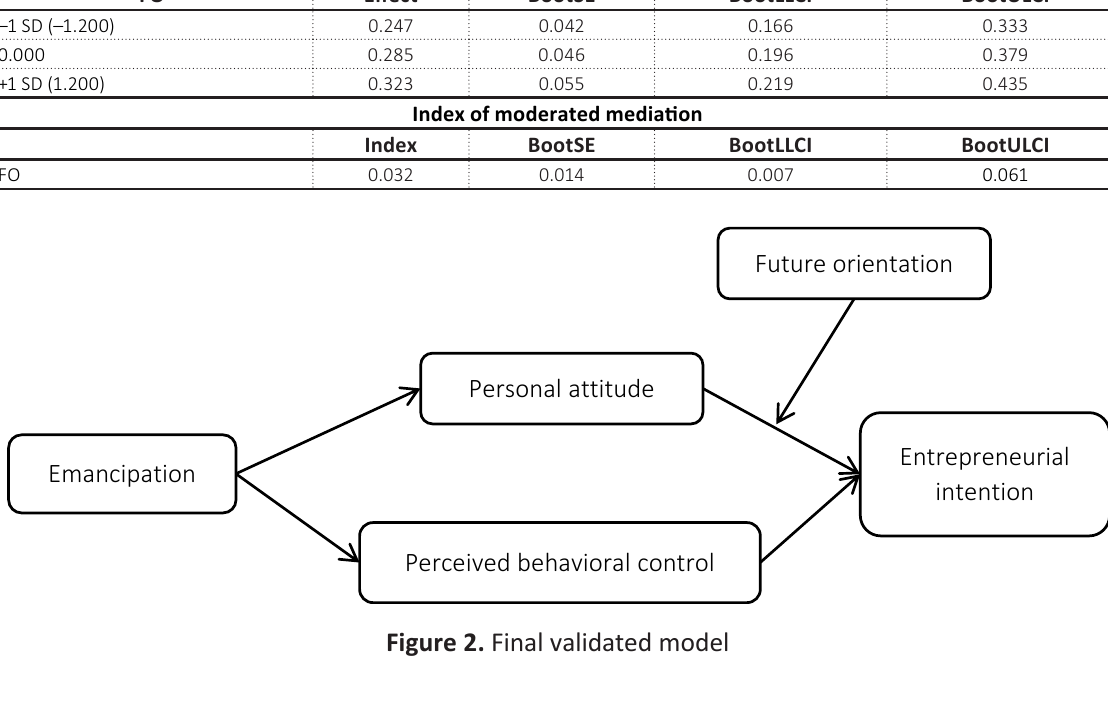
Entrepreneurial intention